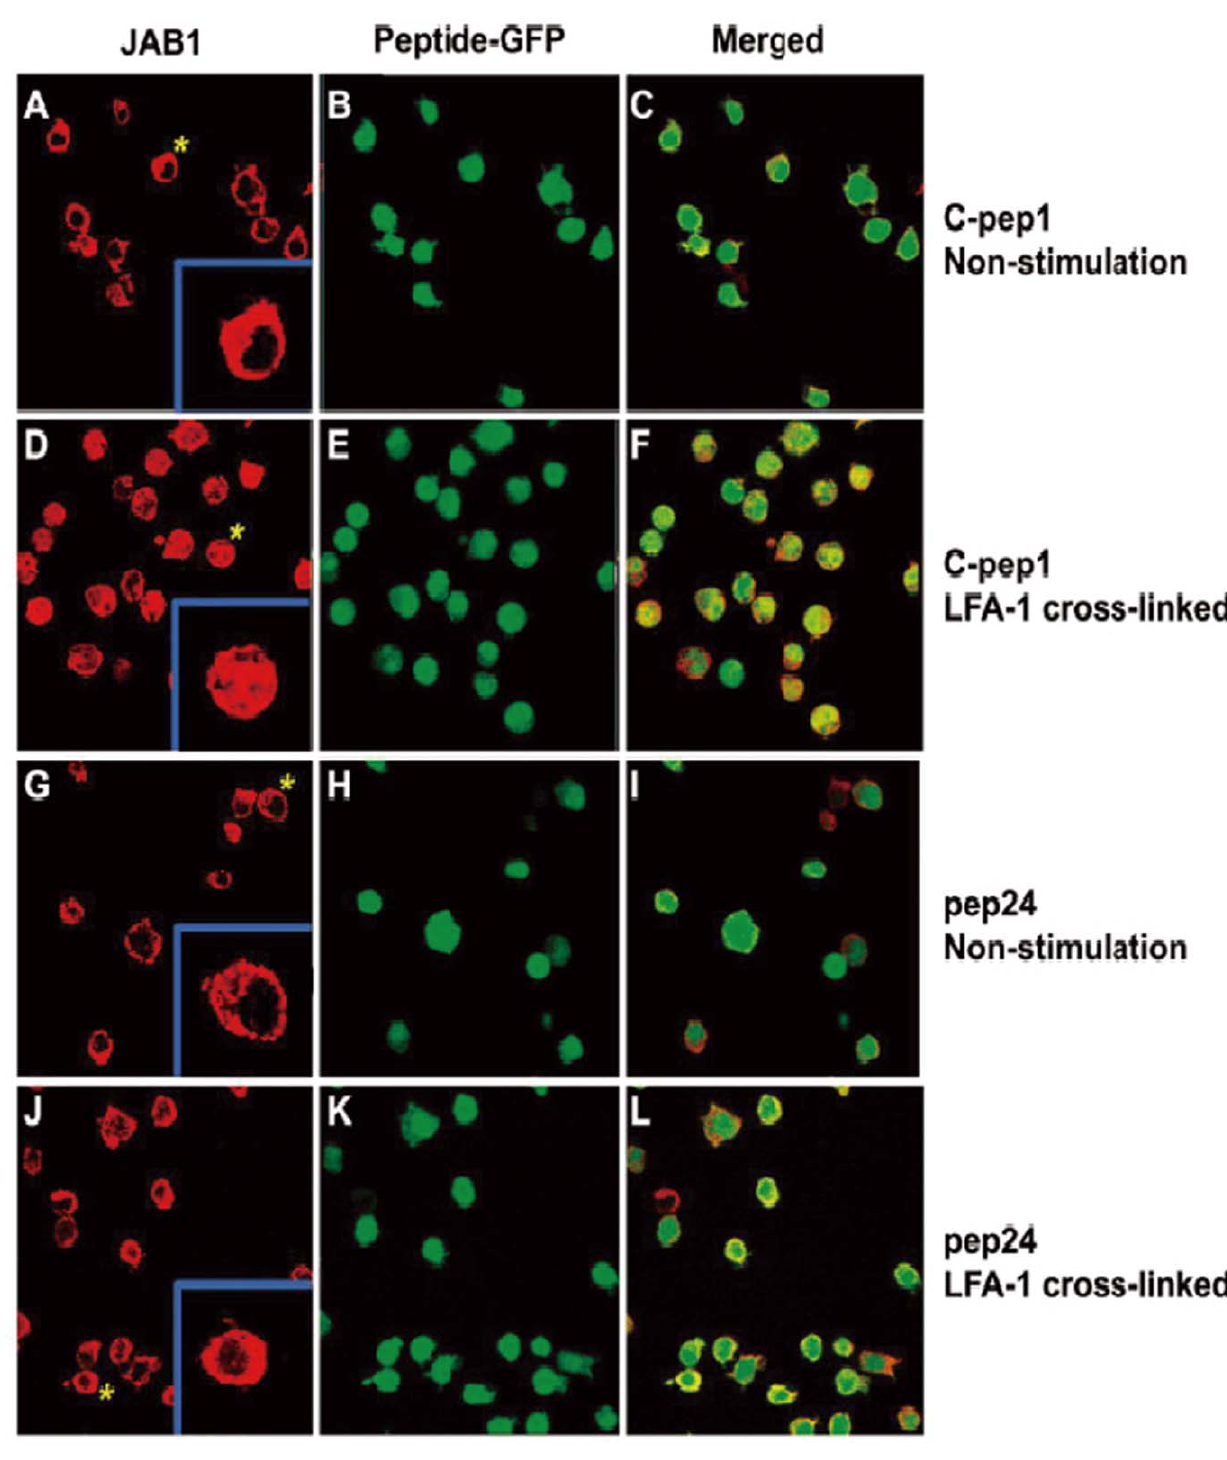
Figure 7. Pep24 blocks LFA-1-induced JAB1 relocalization. Jurkat cells expressing indicated peptides were adhered to either anti-LFA-1 mAb or control IgG coated plates for 30 min. After cross-linking stimulation, cells were stained for JAB1 (red). GFP (green) is an indicator of peptide expression. (A–C) C-Pep1-expressing cells without stimulation. (D–F) C-pep1-expressing cells with LFA-1 cross-linking stimulation. (G–I) Pep24- expressing cells without stimulation. (J–L) Pep24-expressing cells with LFA-1 cross-linking stimulation.